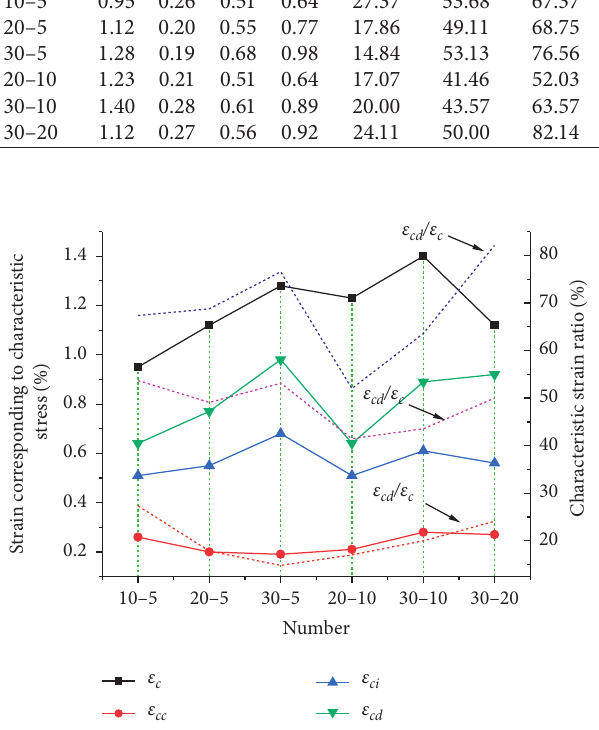
Figure 12: Variation law of characteristic strain and ratio under different confining pressure and pore water pressure